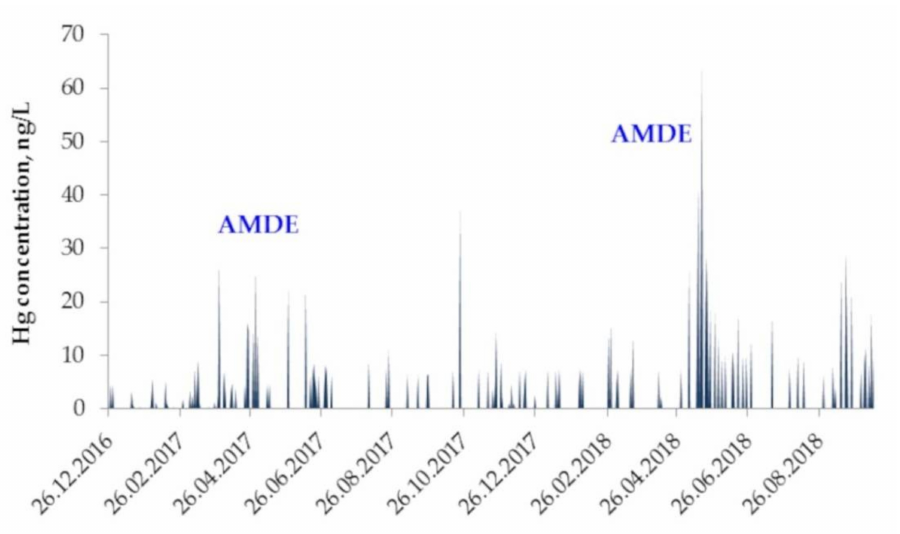
Figure 6. Mercury concentrations in wet precipitation in Nadym during